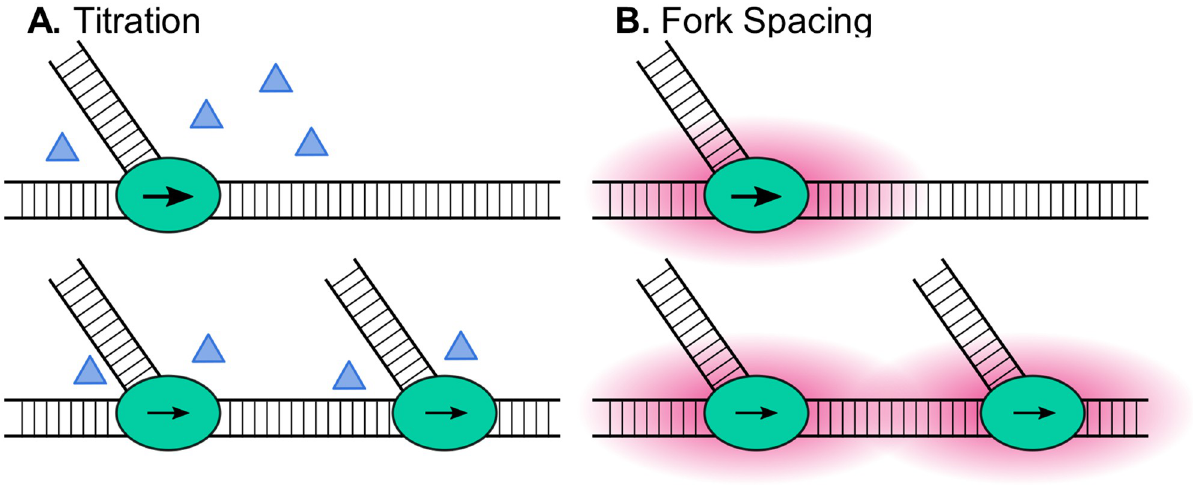
Fig 7. Two hypothesized models for C period decrease as growth rate increases. (A) Titration. (B) Fork spacing. Ovals represent active replisomes, triangles represent accessory replisome components and dNTP substrates, arrows represent relative replisome speed, and red clouds around the replisome represent steric repulsion and topological changes that alter replisome